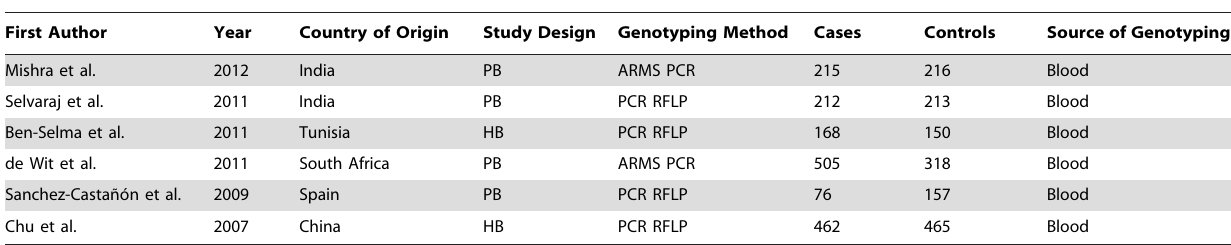
Table 1. Main characteristics of all studies included in the